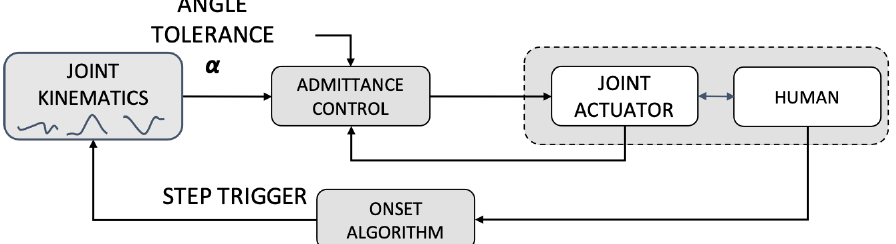
Figure 3. Conceptual diagram of EMG onset-based control loop designed for this experiment and implemented with